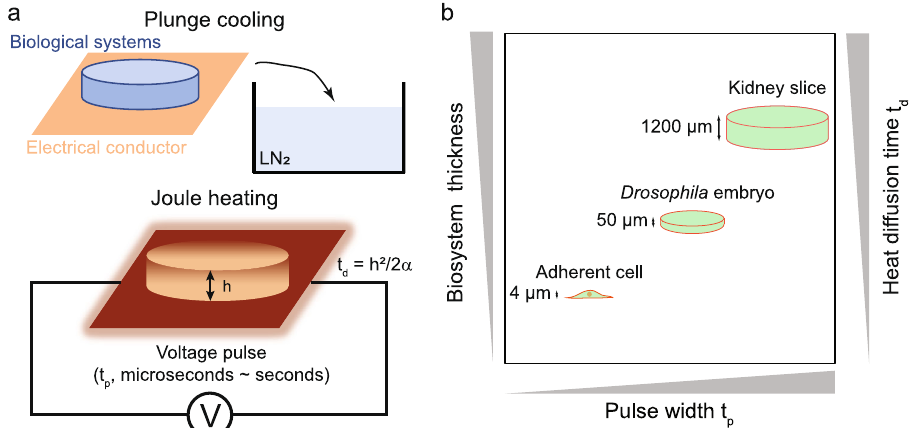
Fig.1|Arapidandscalablerewarmingplatformtechniqueusingjouleheating. a